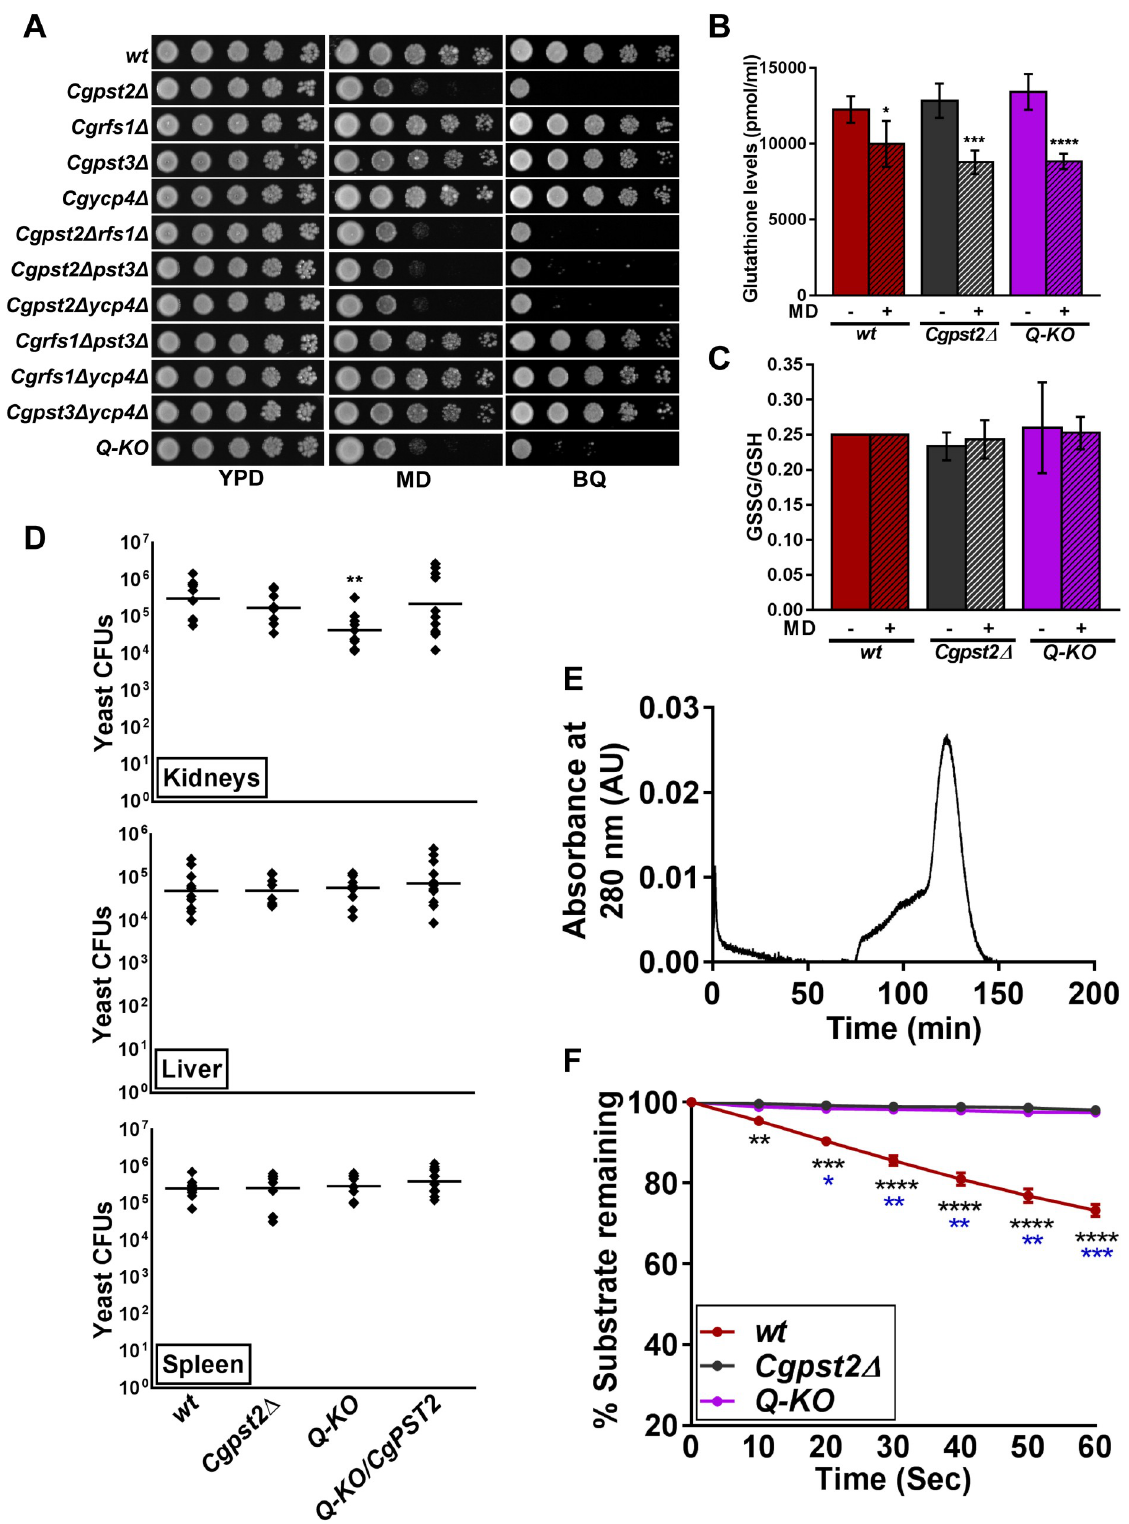
Fig 1. The flavodoxin-like protein CgPst2 plays an essential role in menadione and benzoquinone resistance. A. Serial dilution spotting assay illustrating MD (95 μ M) and BQ (4 mM) sensitivity of indicated C . glabrata mutants. The Q-KO strain lacks four